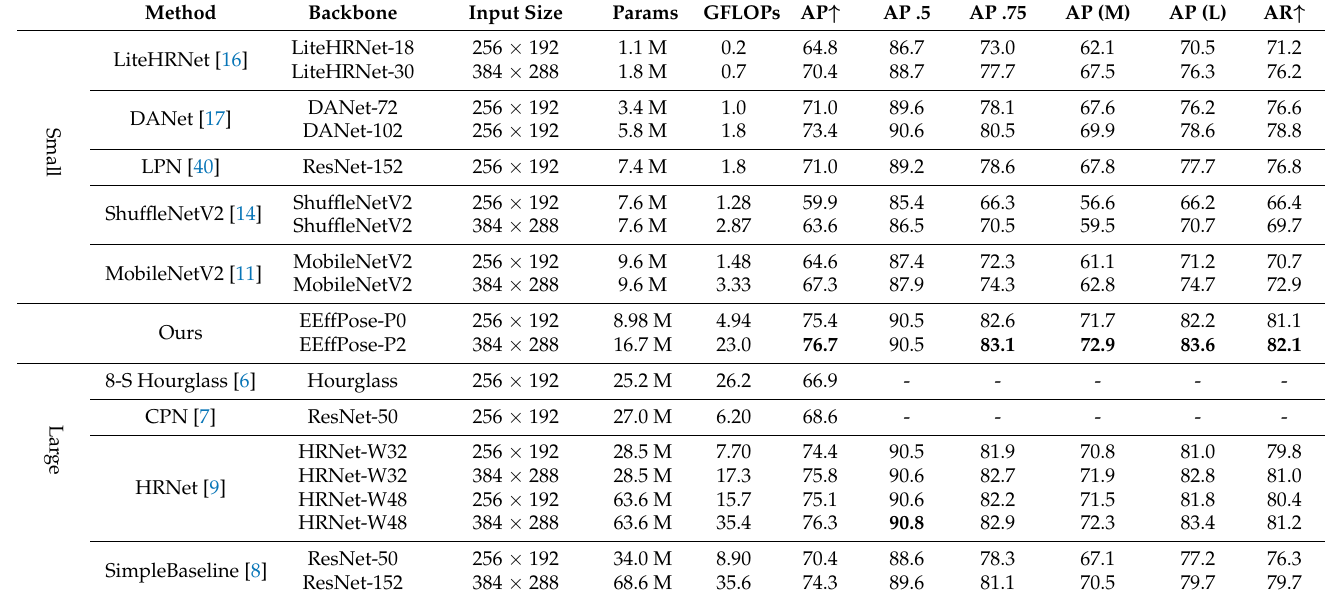
Table 2. Comparisons to the state-of-the-art on the COCO val set.